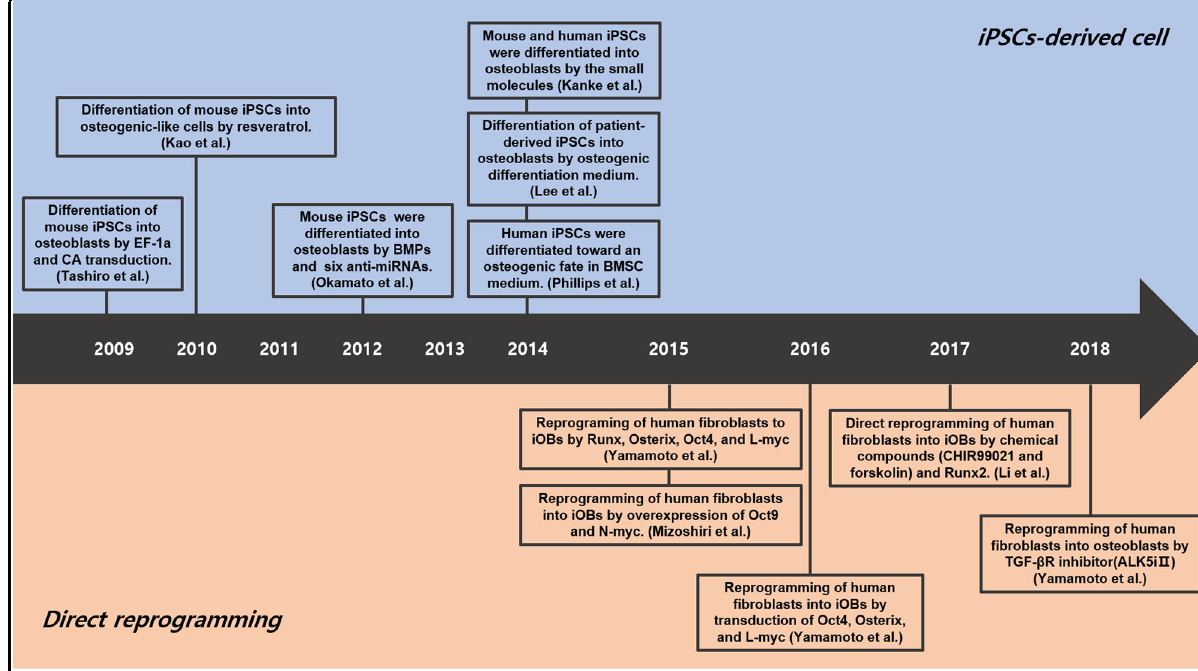
Fig. 2 Timeline for the development of osteogenic cells. The upper panel shows the development of iPSC-derived osteogenic cells, whereas the lower panel shows the development of direct conversion-derived osteogenic